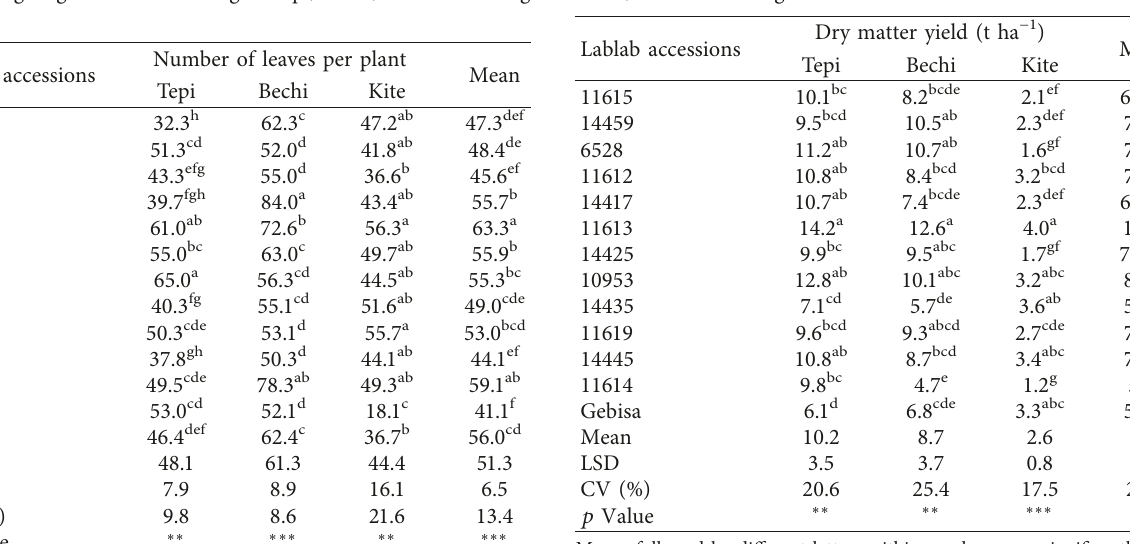
Table 7: Dry matter forage yield (t ha − 1 ) of lablab accessions at Tepi, Bechi, and Kite testing